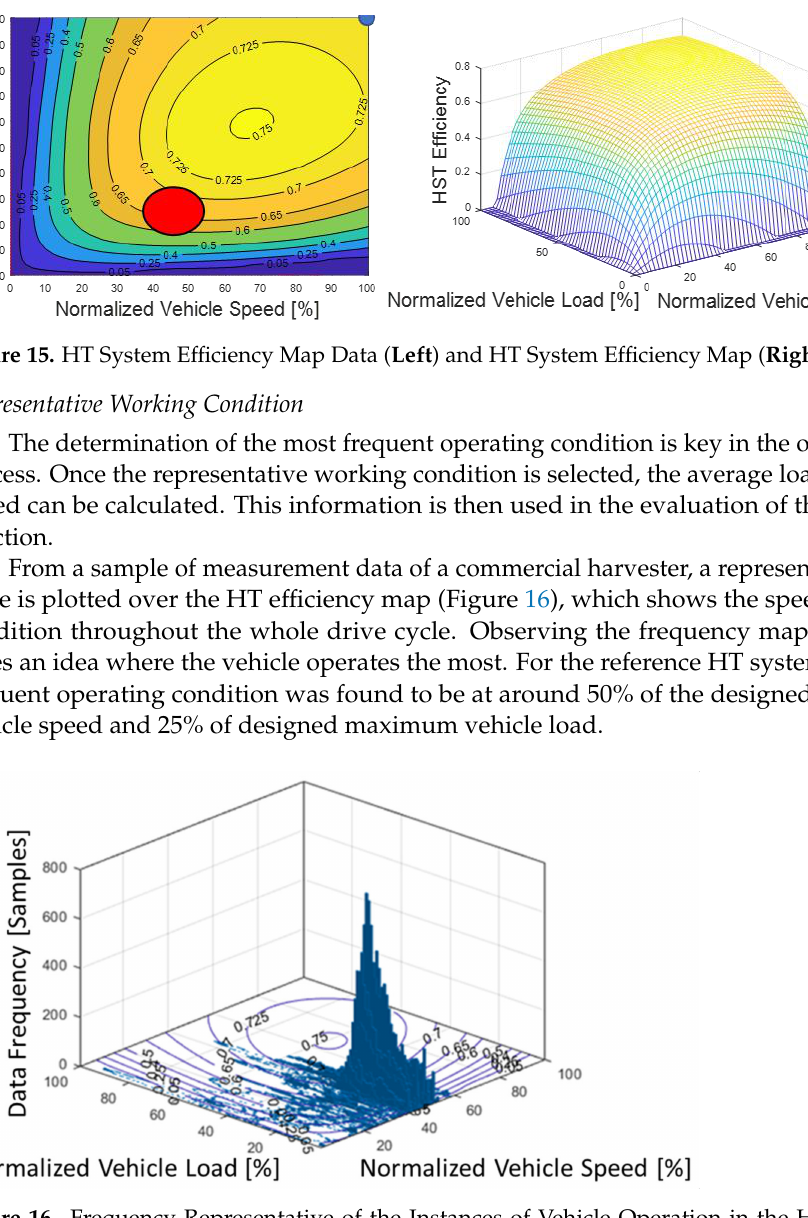
Figure 14. Measured vs. Simulated Normalized Load Pressure (Up is Full Drive Cycle; the lower image is Zoomed in for the First 10% of the time).